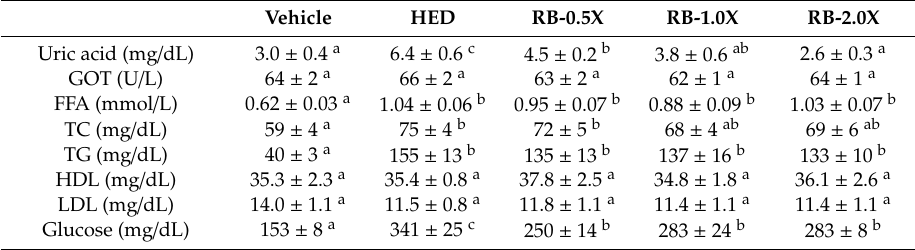
E ff ect of RB on the serum biochemical parameters in rats with high-energy diet (HED)-induced obesity. Vehicle HED RB-0.5X